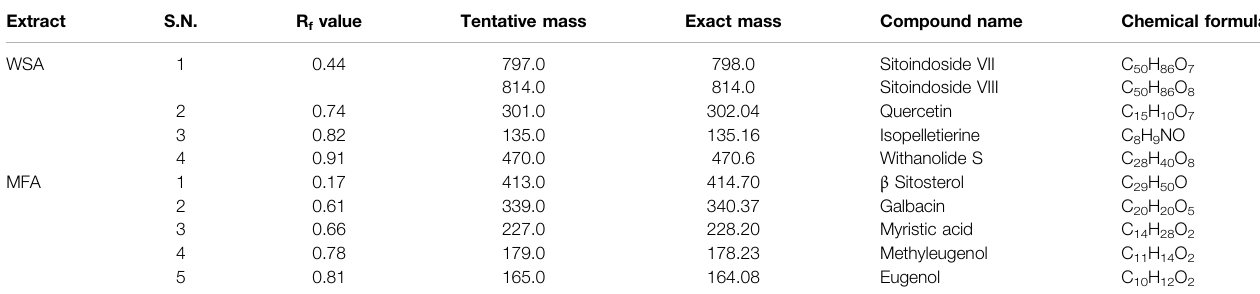
TABLE 4 | Isolated bioactive metabolites from WSA and MFA through TLC-MS-bioautography. Extract S.N.